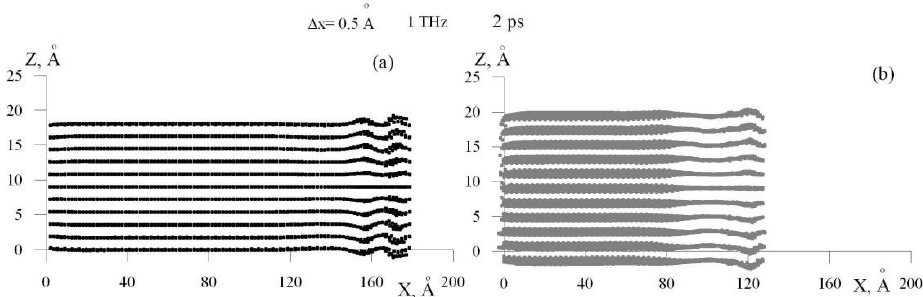
Fig. 10. Outlook of the initially perfect ( а ) and amorphized (b) nanorod at the time instant 2 ps.  x 0 = 0.5 Å,  =1